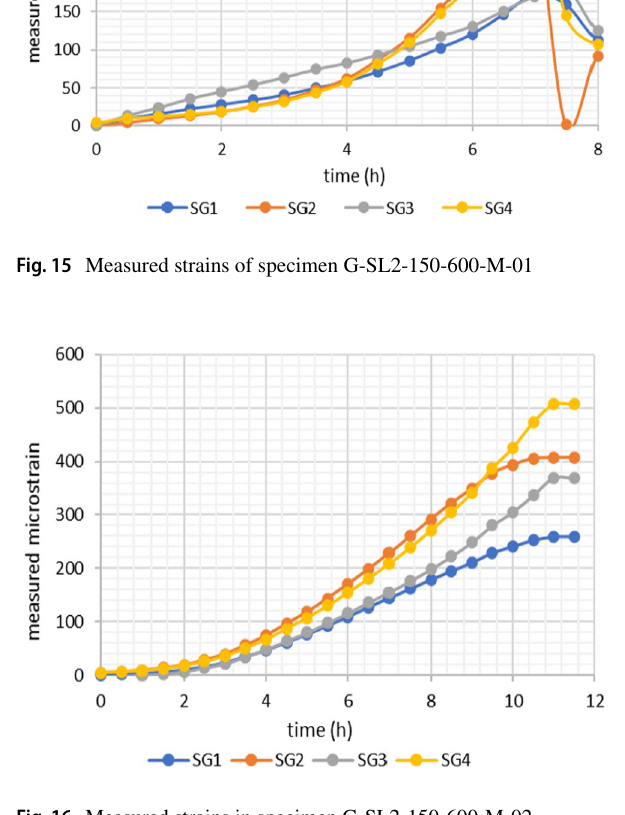
Fig. 16 Measured strains in specimen